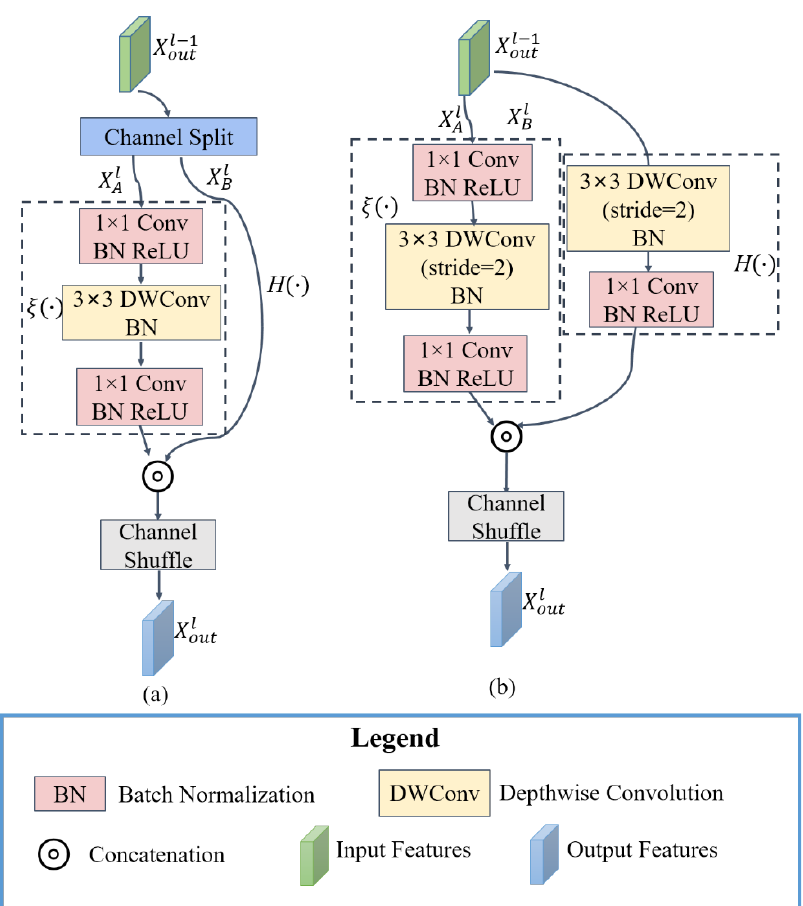
Figure 2. Architecture of the base block. ( a ) Stride = 1; ( b ) stride = 2.